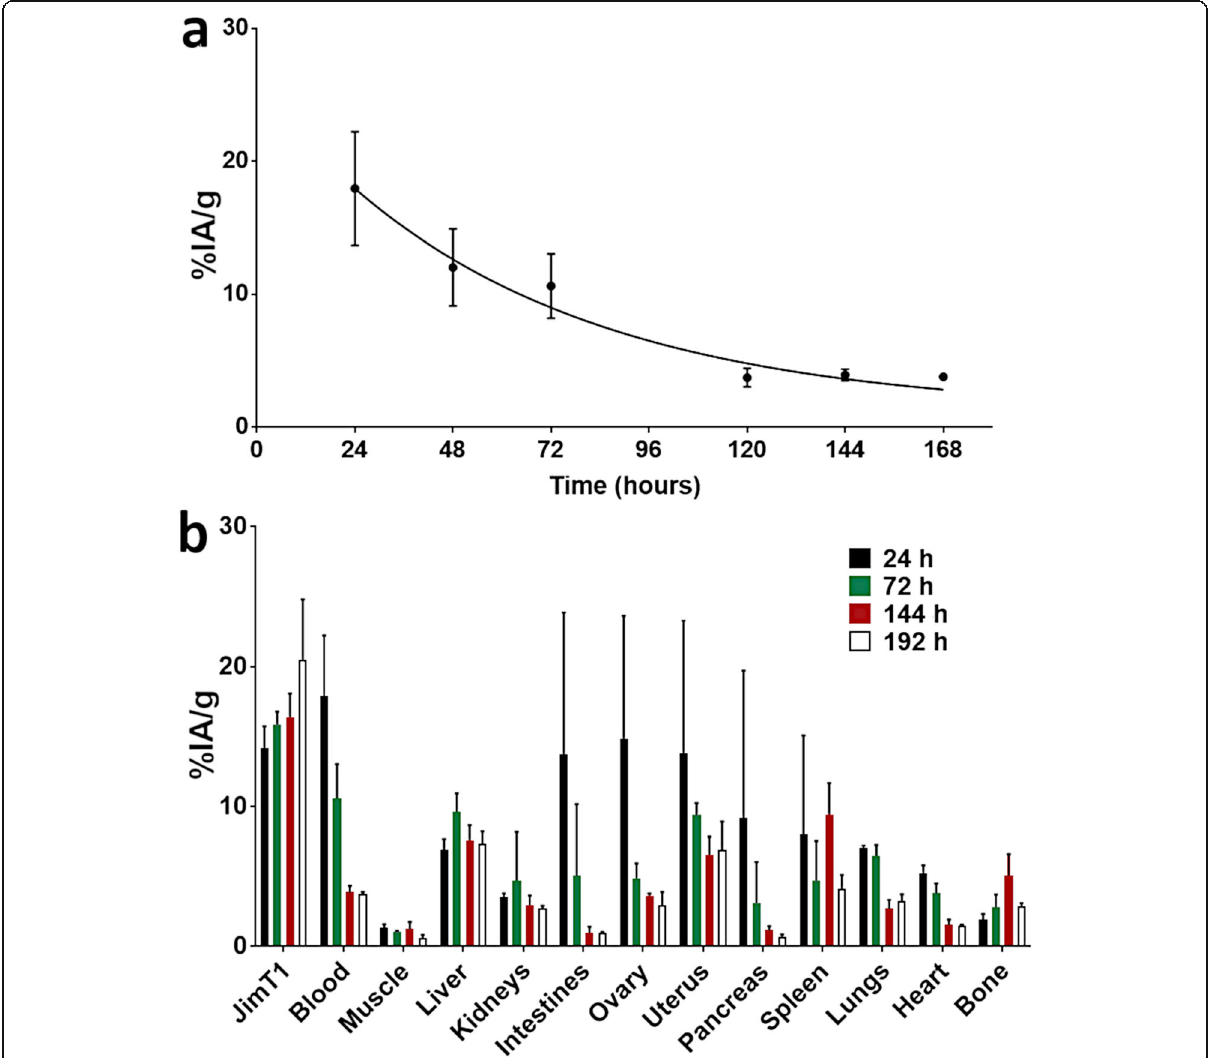
Fig. 2 Pharmacokinetic assessment of 89 Zr-T. a Blood curves derived from serial blood sampling. A mono-exponential fit, with formula y = 22.1e − 0.012x ( R 2 = 0.92) yielded a blood clearance half-life of 75 h. b Biodistribution profile at 24, 72, 144, and 168 h post-injection of 89 Zr-T obtained from dissected organs. JIMT-1 tumors are the only tissue showing a continuous uptake increase through time, while most non-specific organs harbor either a decline or a stable uptake in the same time